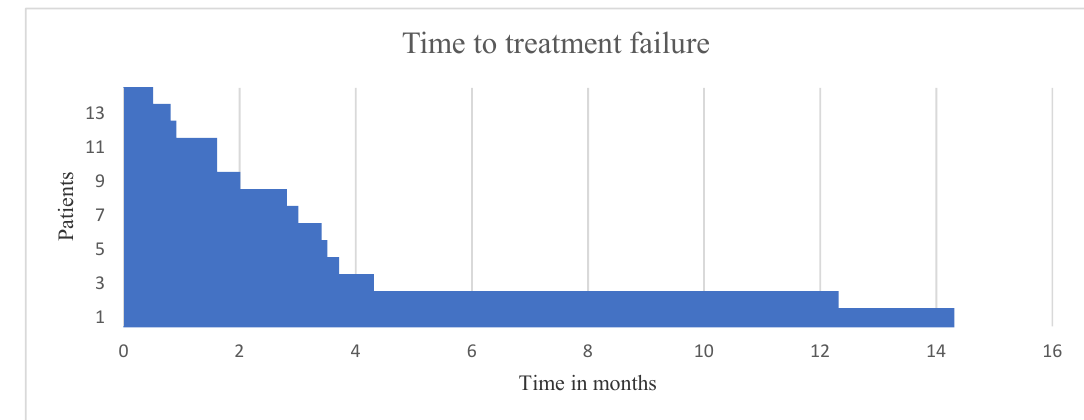
Figure 1. Time to treatment failure (TTF) in the 14 R/M HNC patients who received the recommended targeted therapy.